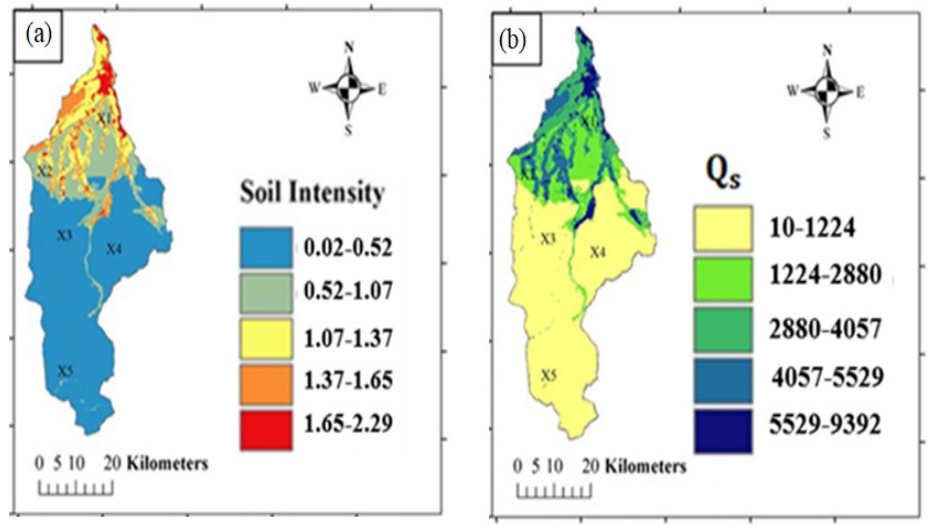
Figure 7. ( a ) Erosion intensity coefficient; ( b ) annual rate of sediment yield in the Babolroud water-